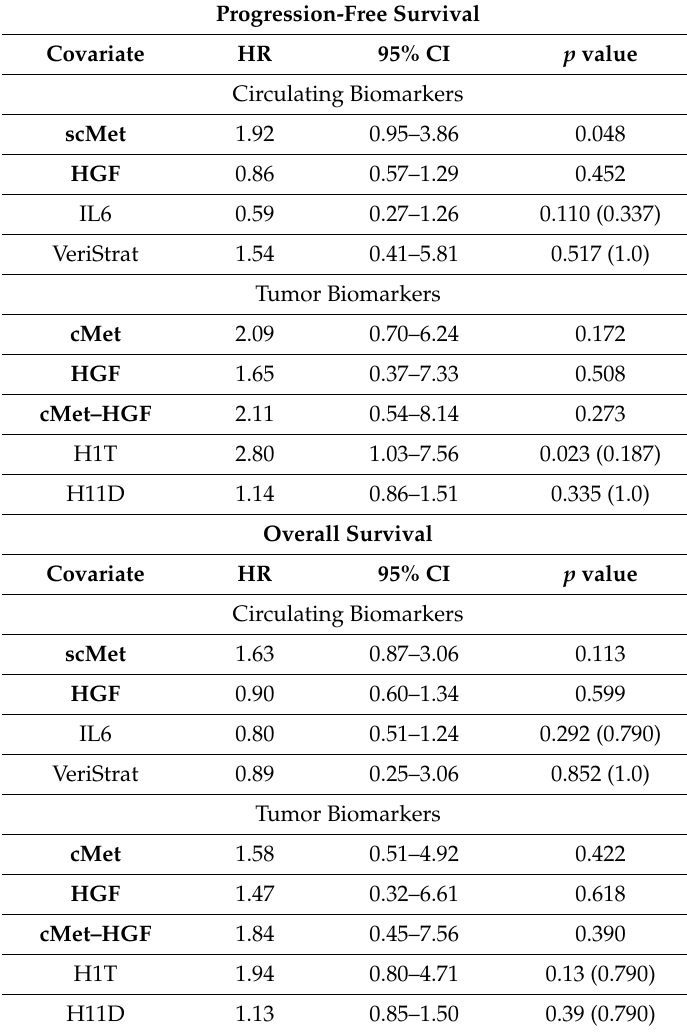
Table 3. Hazards ratios and confidence intervals for proportional-hazards regression of PFS and OS for baseline circulating and tumor markers. HR = hazards ratio; CI = confidence intervals. Prespecified markers are indicated in bold. Adjusted p values are shown in parentheses for markers that were not prespecified in the